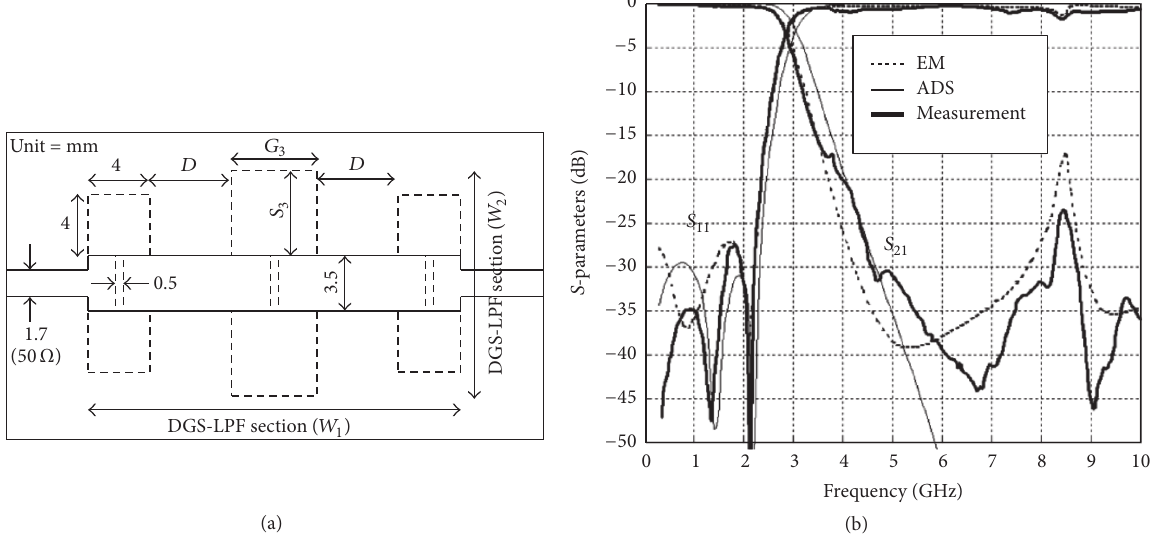
Figure 12: Five-pole DGS-LPF, (a) schematic, and (b) 𝑆 -parameter response